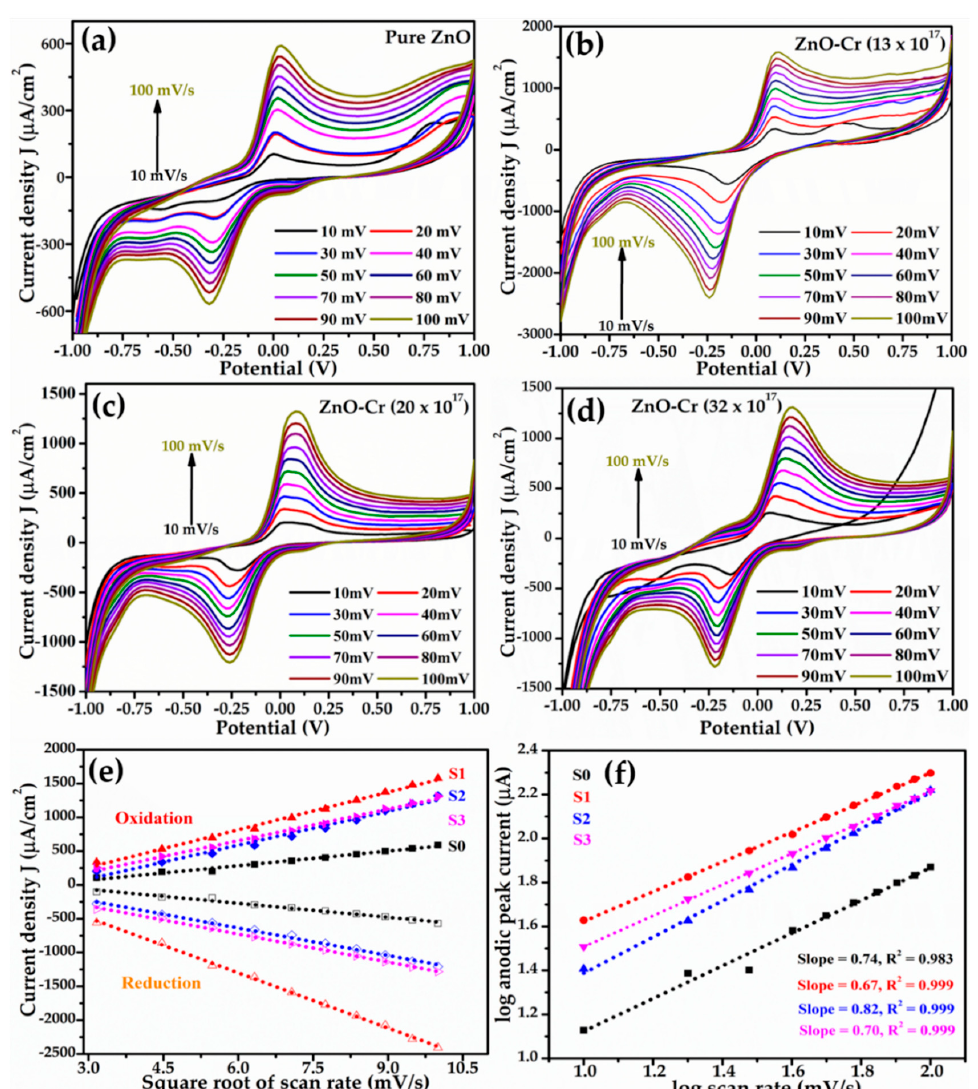
Figure 6. Effect of scan rate on the CV characteristics obtained at 7 nM of Mb for the electrodes made from ( a ) pure ZnO; ( b ) ZnO-Cr (13 × 10 17 atoms/cm 3 ); ( c ) ZnO-Cr (20 × 10 17 atoms/cm 3 ), and ( d ) ZnO-Cr (32 × 10 17 atoms/cm 3 ). ( e ) Peak current (both oxidation and reduction) versus square root of scan rates, and ( f ) log of peak current (oxidation) versus log of scan rate. The symbol represents experimental data points and dotted line is the best fit obtained.